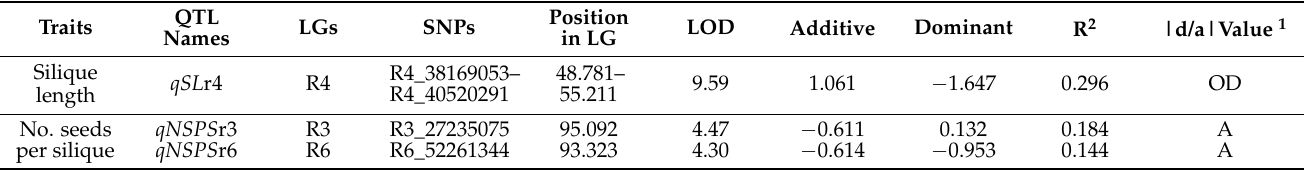
Table 2. Summary of the QTL regions related to seed production traits in radish, including linkage groups (LGs), single nucleotide polymorphism (SNP), position in LG, logarithm of the odds (LOD) score, values for additive or dominant effect, proportion of variance explained by each QTL (R 2 ) and estimated gene action (|d/a|).